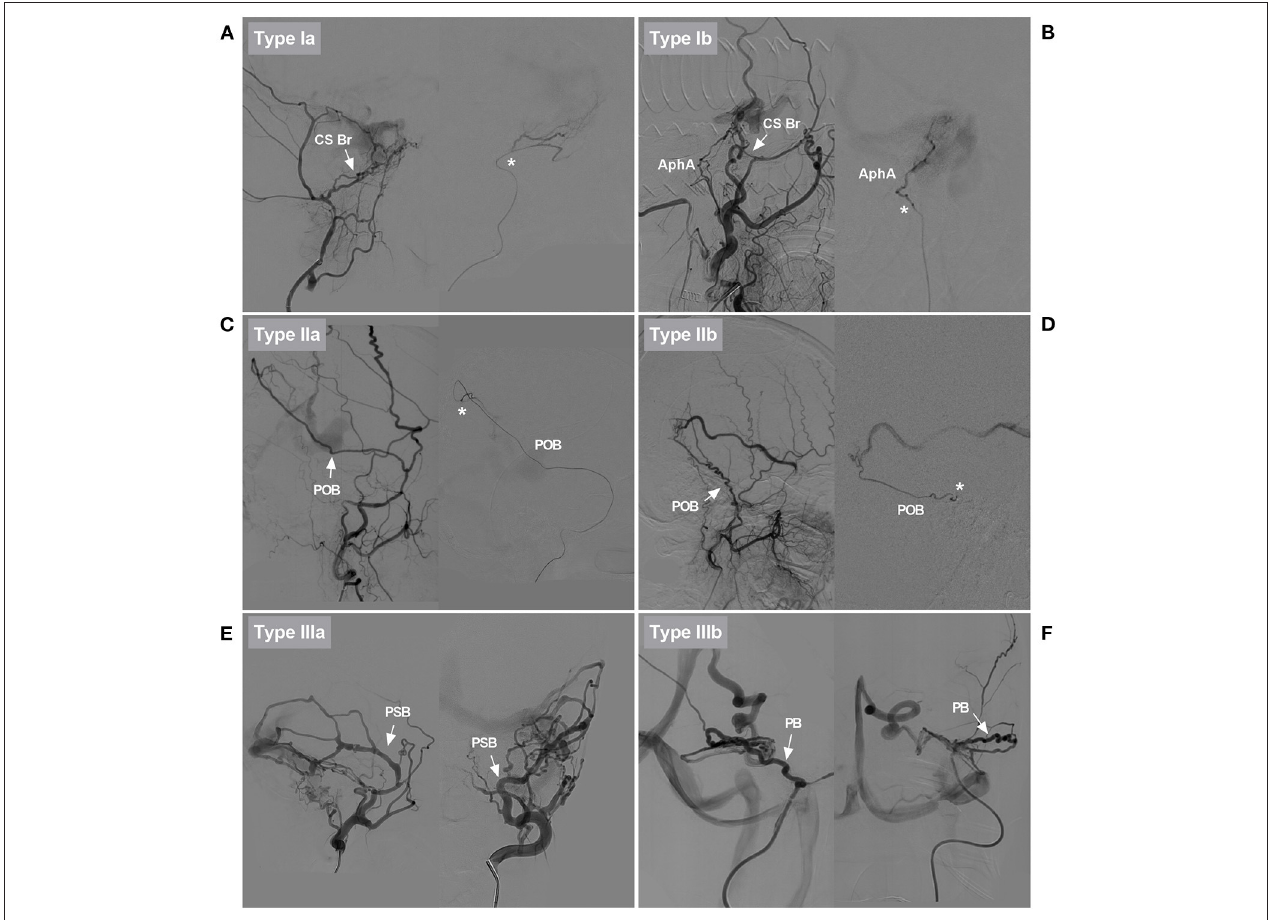
FIGURE 3 | Classification of EVTs based on the role of the MMA. (A) DSA showed that the CS branch of the MMA in type Ia EVT was slim and tortuous (arrow). Superselective angiography showed the CS branch (asterisk). EVT was delivered via that vessel. (B) DSA showed that the CS branch of the MMA in type Ib EVT was slim and tortuous (arrow). EVT was delivered via the AphA, which was thicker than the CS branch. AphA was shown on superselective angiography (asterisk). (C) DSA showed that the POB of the MMA in type IIa EVT was normally developed, sufficiently thick, and straight (arrow). Superselective angiography showed the POB (asterisk). EVT was delivered via that vessel. (D) DSA showed that the PSB of the MMA in type IIb EVT was normally developed, but it was tortuous. Superselective angiography showed the PSB (asterisk). Because there was no other suitable artery, the PSB was used to deliver EVT. (E) Different DSA views showed that the PSB of the MMA in type IIIa EVT was overdeveloped and straight (arrows). EVT was delivered via that vessel. (F) Different DSA views showed that the PB of the MMA in type IIIb EVT was overdeveloped and tortuous (arrows). EVT was delivered via that vessel. AphA, ascending pharyngeal artery; Br, branch; CS, cavernous sinus;